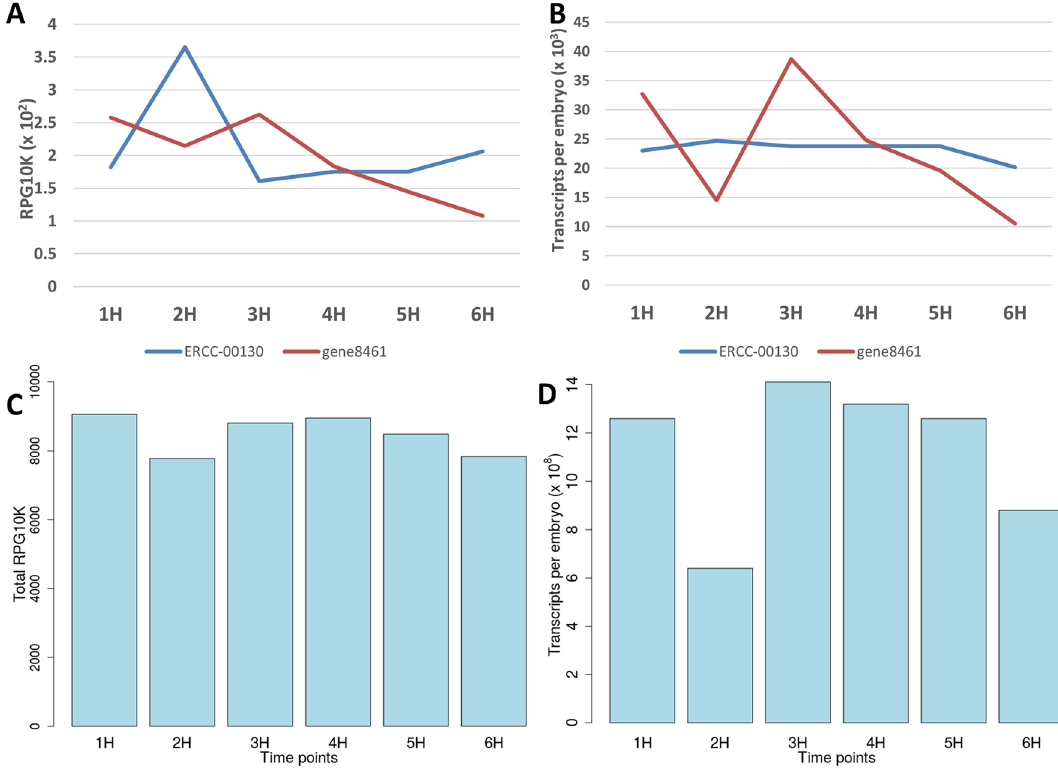
Figure 2. Comparison of relative and absolute normalization. ( A ) Relative gene expression quantification of ERCC internal spike-in control 00130 (blue) and gene8461 (red) as obtained with Mandalorion software 4 . For each gene Mandalorion reports its quantification as reads per gene per 10,000 mapped reads (RPG10K). ( B ) Same as ( A ) but showing number of transcripts per embryo following absolute normalization (see “Methods”). ( C ) Summed RPG10K for all genes at each timepoint. ( D ) Same as ( C ) but showing total number of transcripts per embryo across the six timepoints following absolute